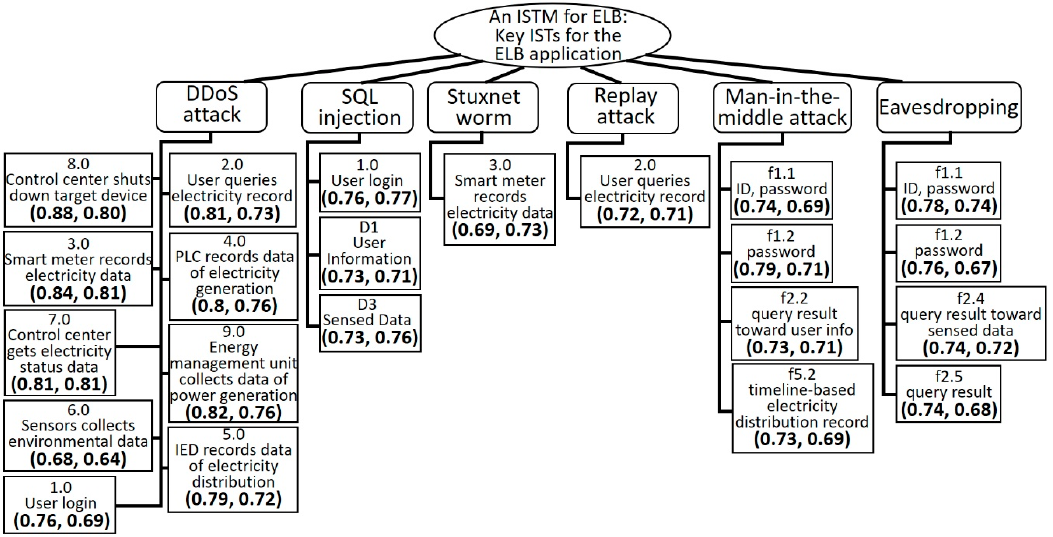
Figure 11. The ISTM result of the ELB practice.